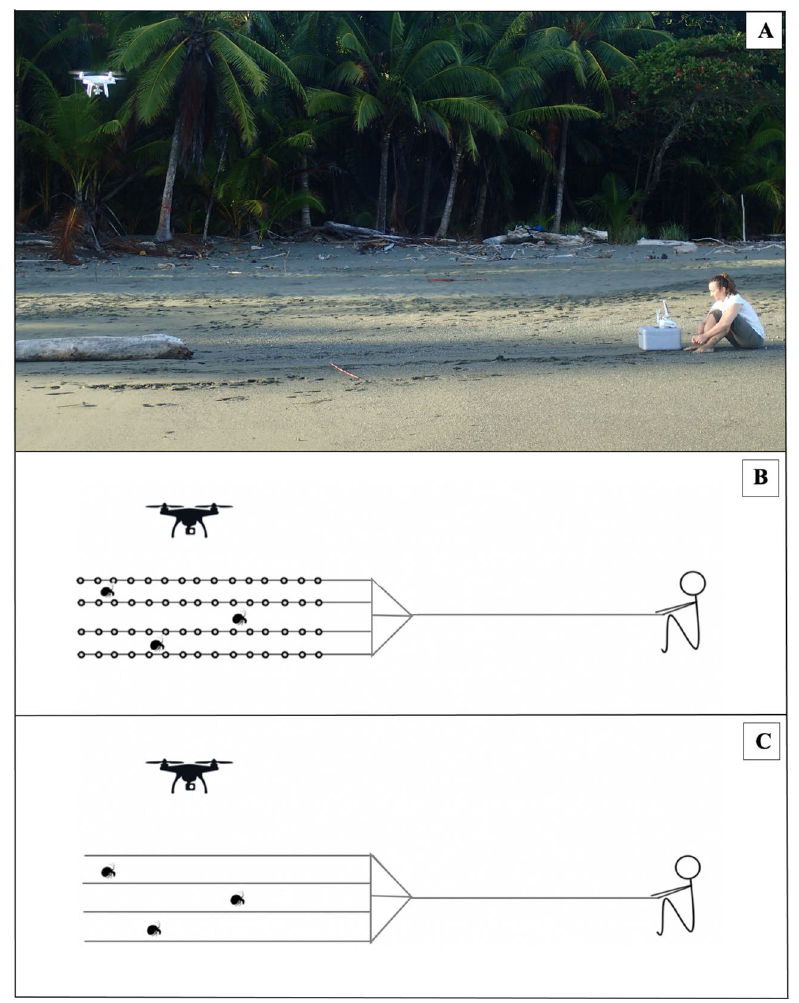
Figure 2. Free-roam experiments: stimuli and experimental design. ( A ) Photograph of a free-roam experiment in progress, with a drone hovering above and one of the authors (CD) pulling the simulated collective (Photo: Jakob Krieger). Schematics of stimuli are shown in B and C, with N = 3 free-roaming crabs also pictured. ( B ) Experimental stimuli: consisting of N = 60 shells arranged in four lines of fifteen shells each, attached to clear fishing line and fixed to a wooden dowel. ( C ) Control stimuli: four empty lines of clear fishing line, fixed to a wooden dowel. An experimenter moved the stimuli from a distance, by pulling another clear fishing line along an open strip of sandy beach in the presence of free roaming crabs. Each experiment was video recorded from above by an overhead